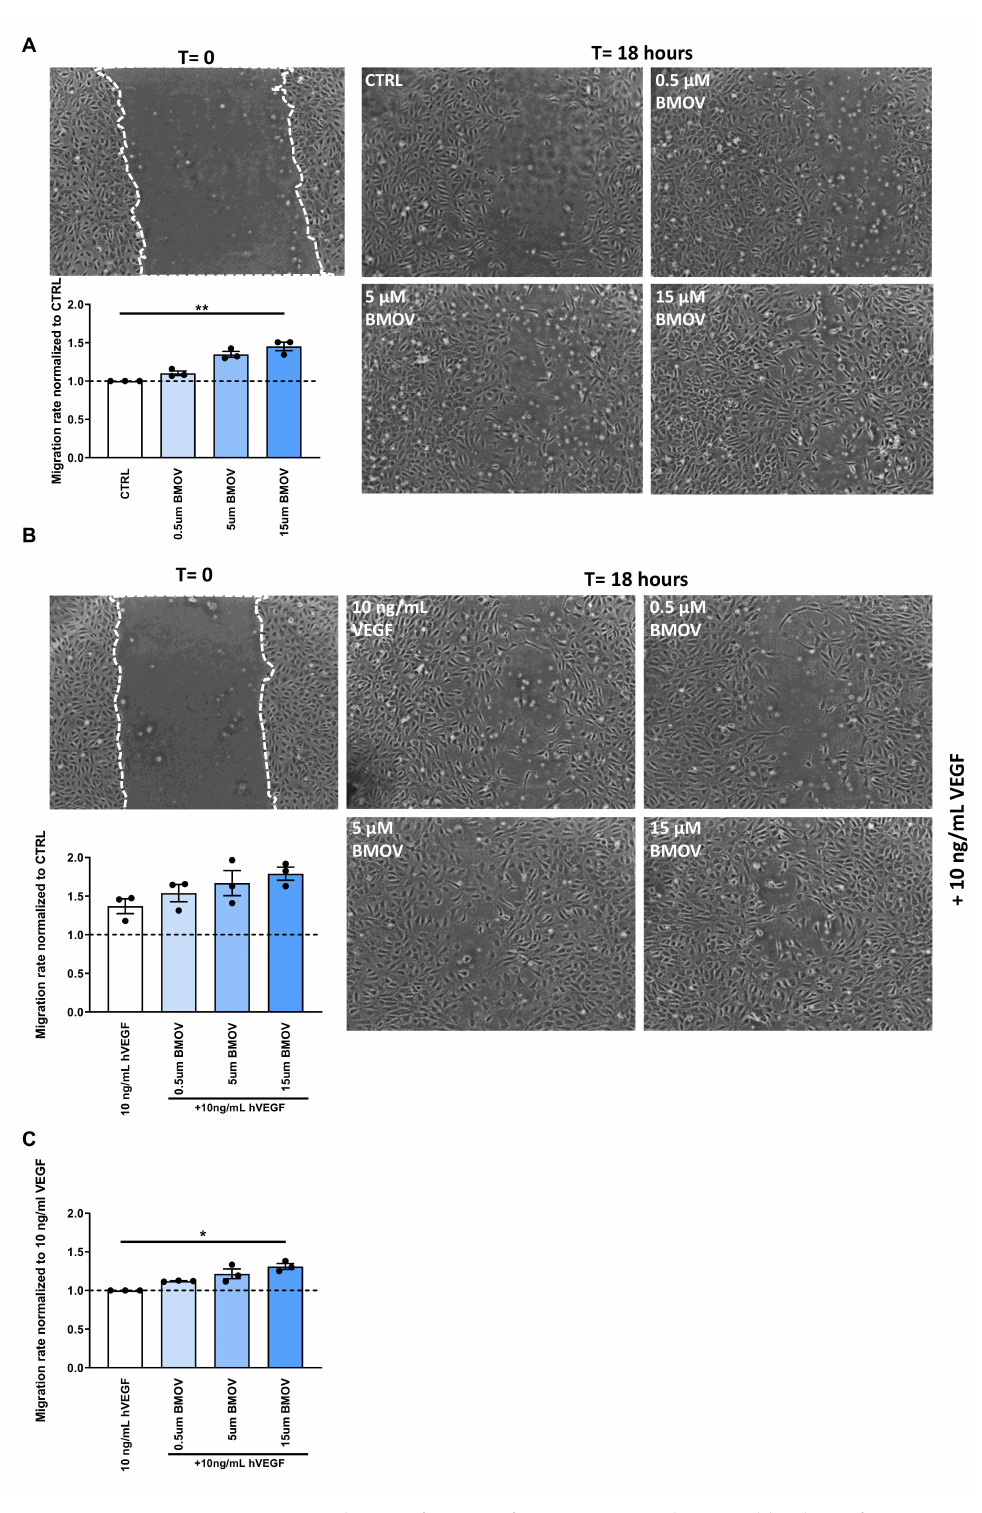
Figure 4. Representative images and quantification of HUVECs scratch-wound healing after treatment with either ( A ) BMOV alone in di ff erent concentrations (0.5, 5, 15 µ M) or ( B ) di ff erent concentrations of BMOV (0.5, 5, 15 µ M) supplemented with 10 ng / mL VEGF-A. ( C ) E ff ect of BMOV in the cell culture supplemented with 10 ng / mL VEGF-A. Datapoints represent averages obtained from 3 independent experiments and are presented as mean ± SEM. * p < 0.05; ** p < 0.01 by Kruskal-Wallis